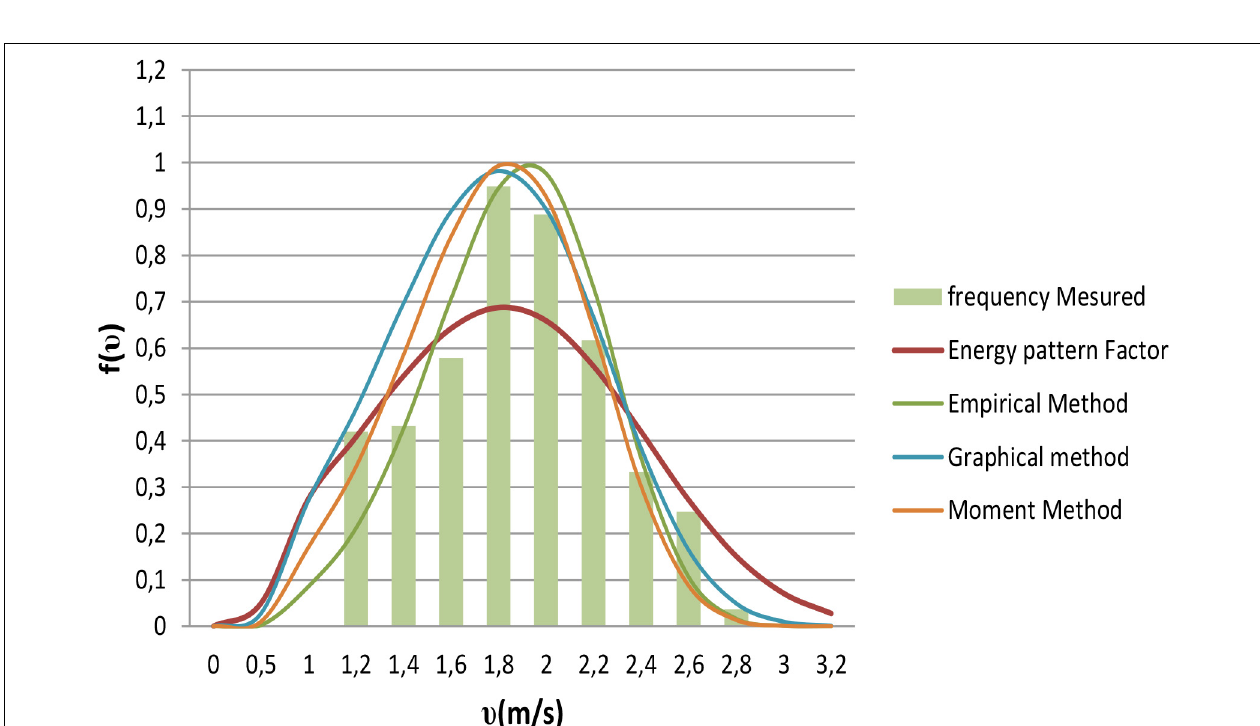
FIGURE 3 | Distribution of Weibull function and frequency measured, year